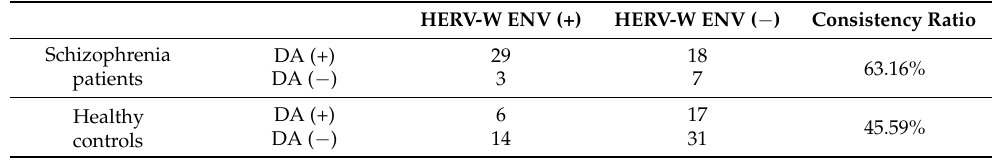
Table 1. The consistence of HERV-W ENV and DA concentration in schizophrenia patients and healthy